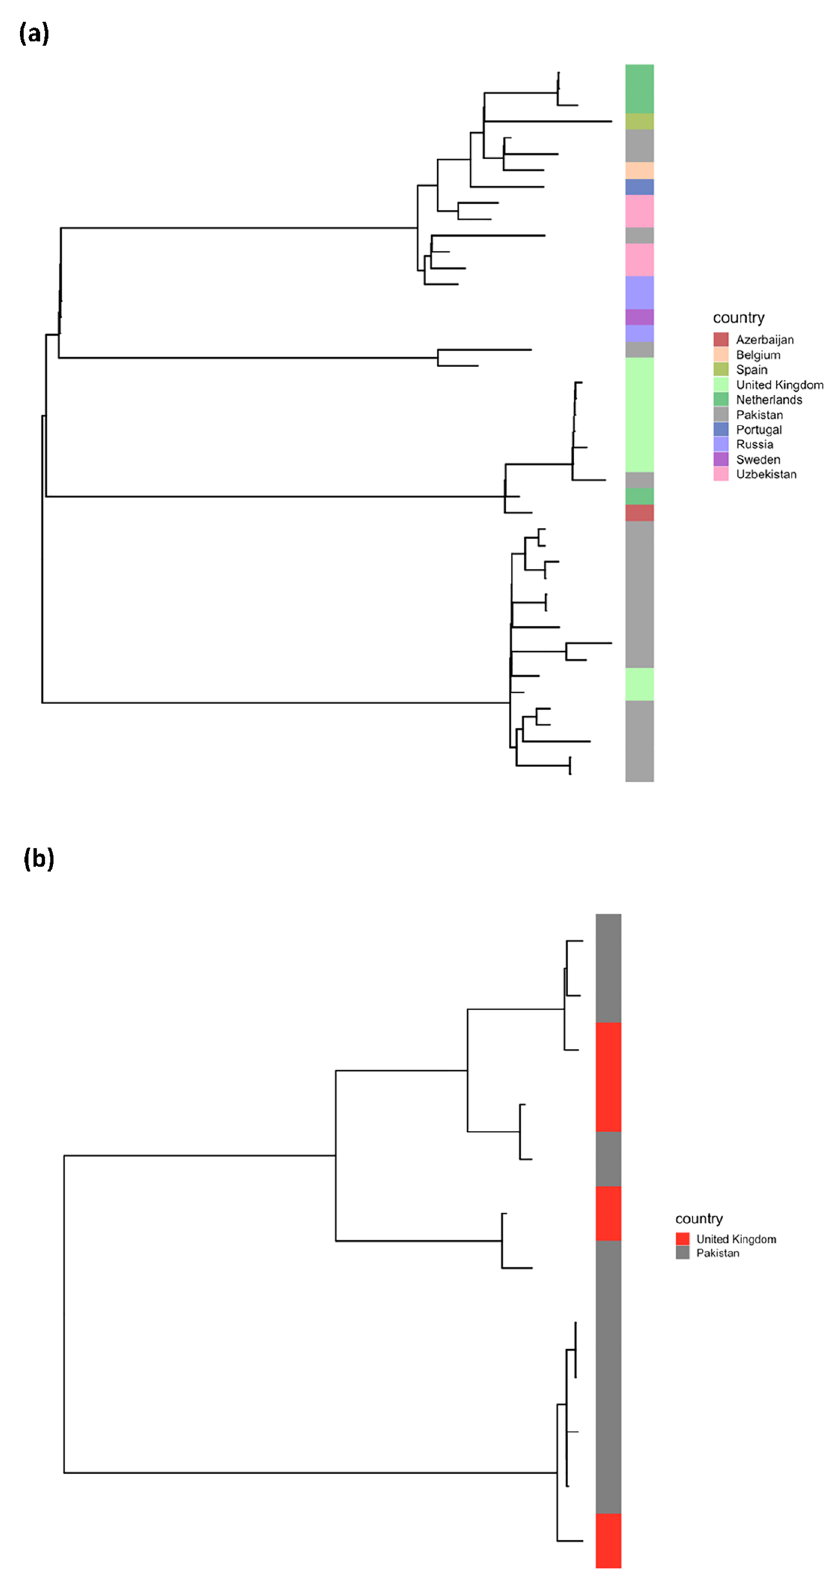
Figure 2. Phylogenetic trees for sub-lineages involving Pakistan samples and closely-related global isolates from previously published datasets. (a) Sub-lineage 2.2.1 (19 Pakistan, 25 other). (b) Lineage 3 (8 Pakistan, 4